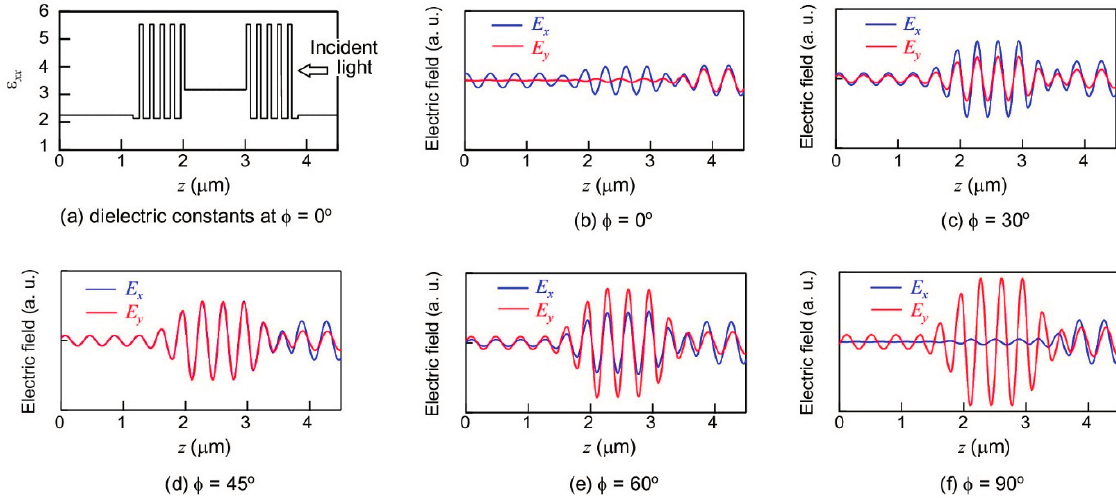
Figure 7. Calculated structure of the 1D PC with the NLC defect: ( a ) ε xx profile at ϕ = 0°. Electric field profiles of E x and E y propagating through the 1D PC with the NLC defect at a wavelength of 595 nm: ( b ) ϕ = 0°, ( c ) ϕ = 30°, ( d ) ϕ = 45°, ( e ) ϕ = 60°, and ( f ) ϕ =